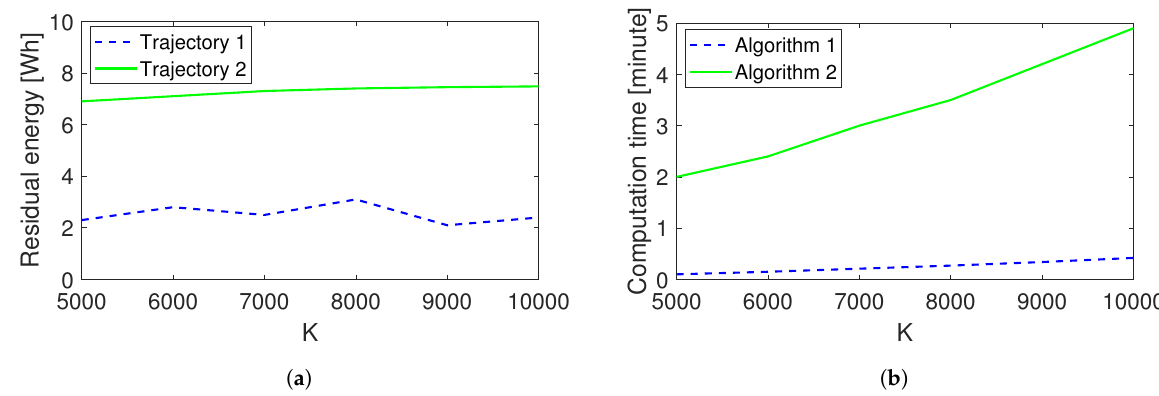
Figure 12. The impact of K on ( a ) residual energy and ( b ) computation time.